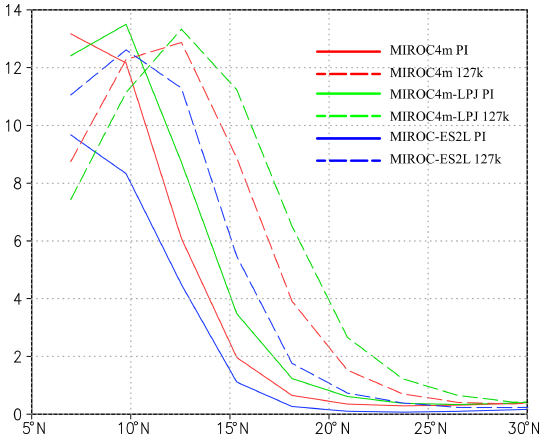
Figure 14. Zonally (30 ◦ W–20 ◦ E) averaged JJA precipitation (mmd − 1 ) over land at 5–30 ◦ N. The calendar for 127k is adjusted using a method based on Bartlein and Shafer